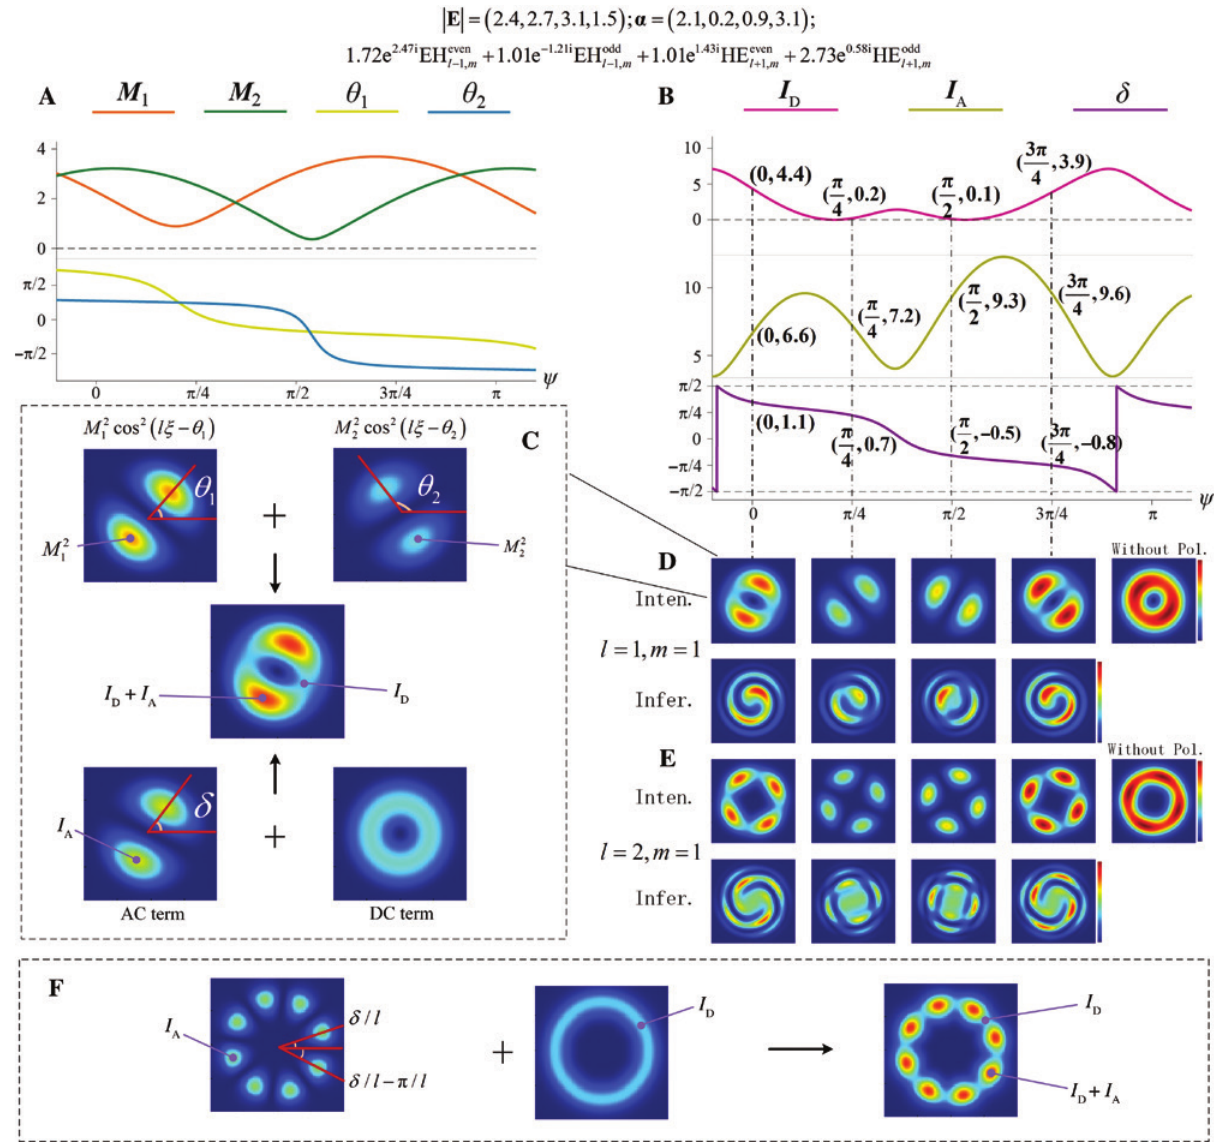
Figure 3: Corresponding relation between the expanded Jones model and mode patterns of a random l th order spatial state, where |E| = (2.4, 2.7, 3.1, 1.5) and α = (2.1, 0.2, 0.9, 3.1)